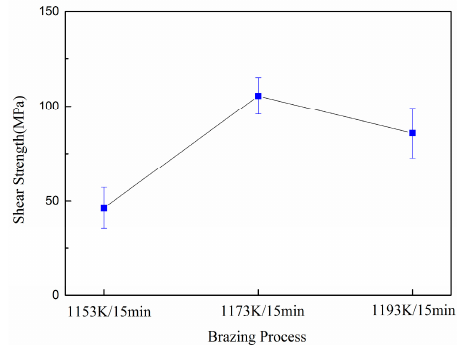
Figure 6. Effect of brazing temperature on the shear strength of TiAl/AgCu/Si 3 N 4 brazed joints.